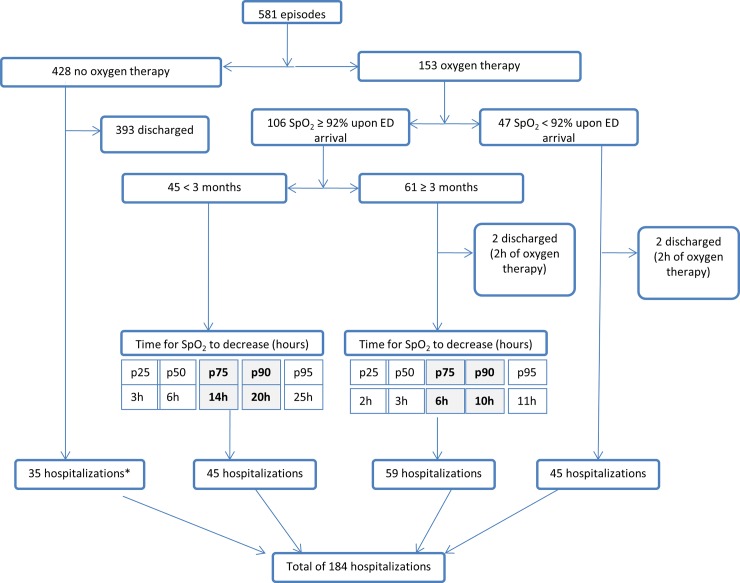
Patients’ outcomes from ED arrival until admission to the hospital or discharge home.*35 patients did not need oxygen therapy but were hospitalized for enteral feeding, social reasons, or observation due to important respiratory distress.